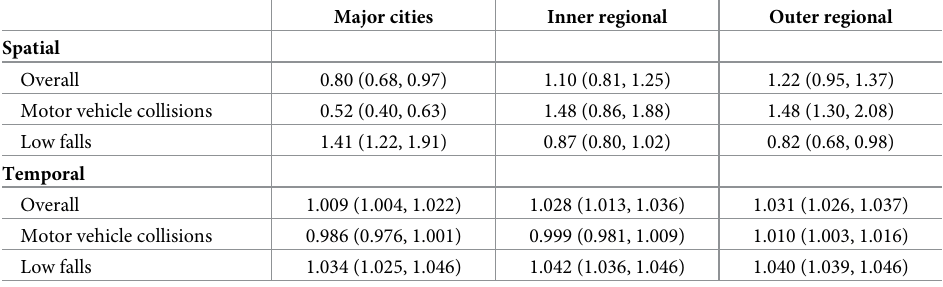
Table 3. Summaries of the posterior means of the area-specific relative risk (‘Spatial’) and the area-specific yearly multiplicative change in risk (‘Temporal’) grouped by the Accessibility and Remoteness Index of Australia (ARIA), classified as major cities, inner regional and outer regional.